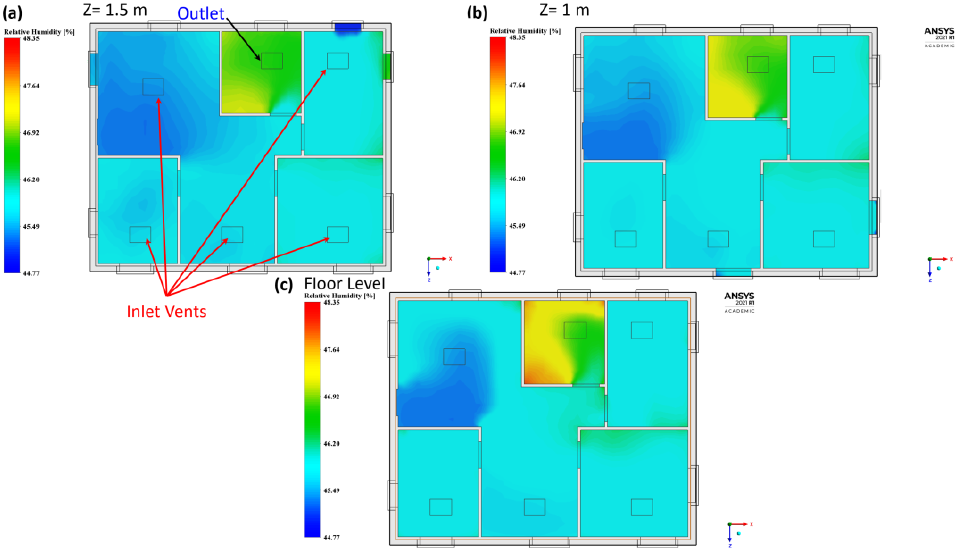
Figure 8. Relative humidity (%) profiles distribution for the house (top view) at different heights ( a ) 1.5 m, ( b ) 1 m, and ( c ) the (finished) floor. The results for the proposed system can be further assessed using the PMV (predicted mean vote) and PPD (predicted percentage dissatisfied) thermal comfort parameters